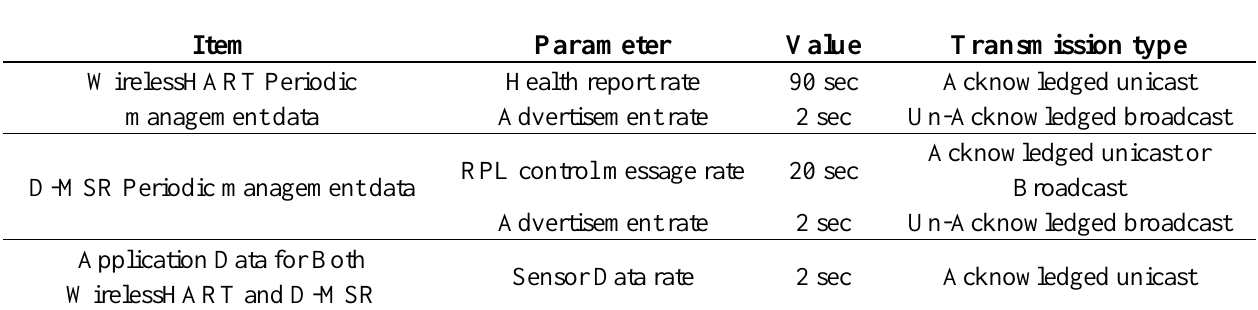
Table 5. Periodic messages